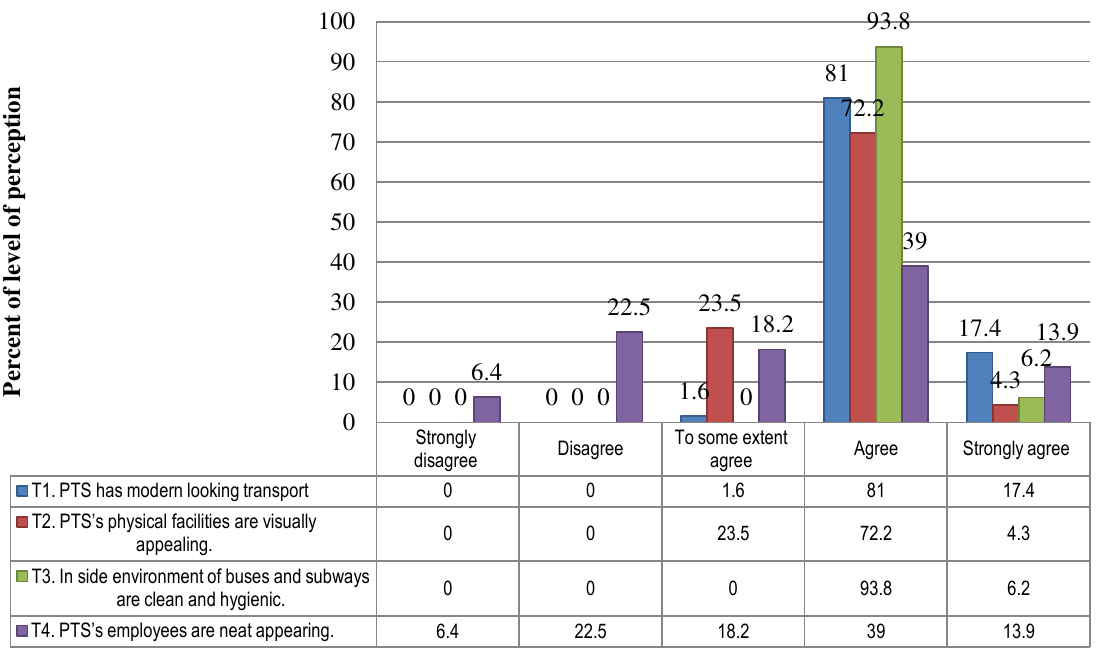
Fig. 7. Level of perception on tangible about PTS percentage of research respondents